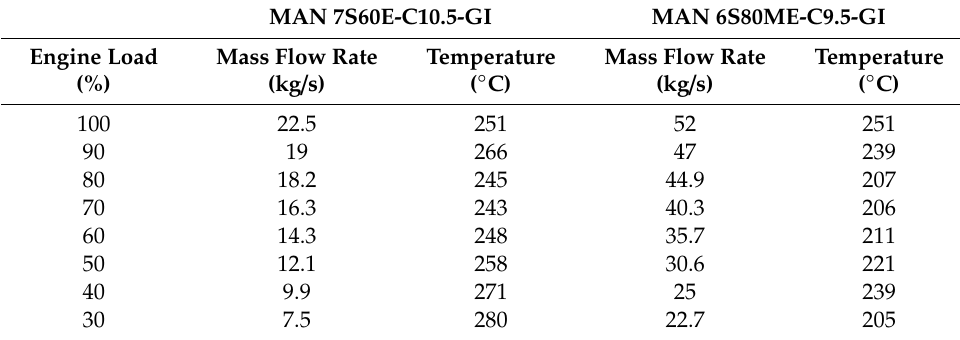
Table 3. Characteristics of the exhaust gases of the two engines as a function of the engine load [36].